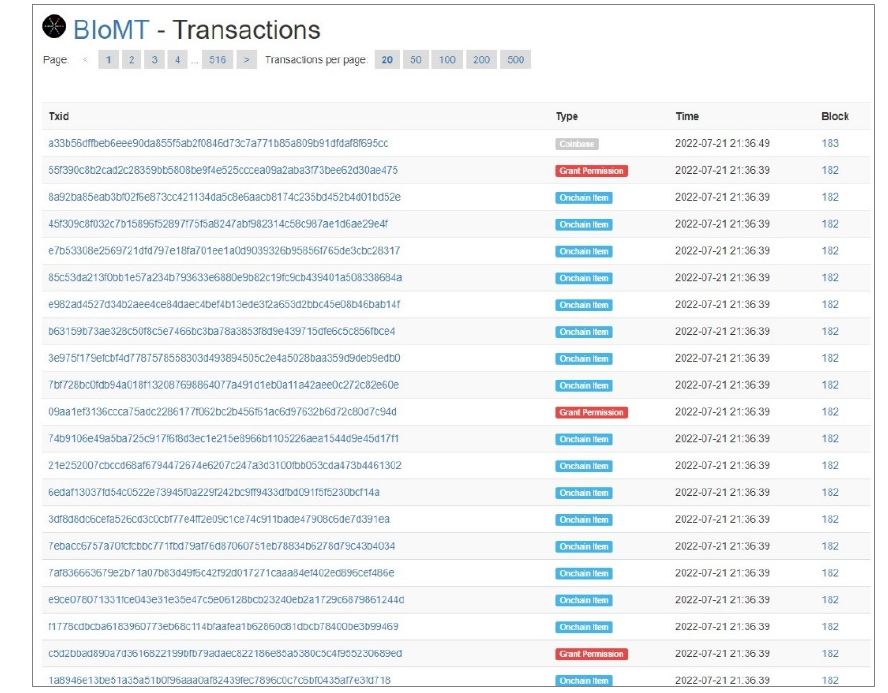
Figure 5. The screenshot of exemplary 21 transactions from the implemented blockchain.